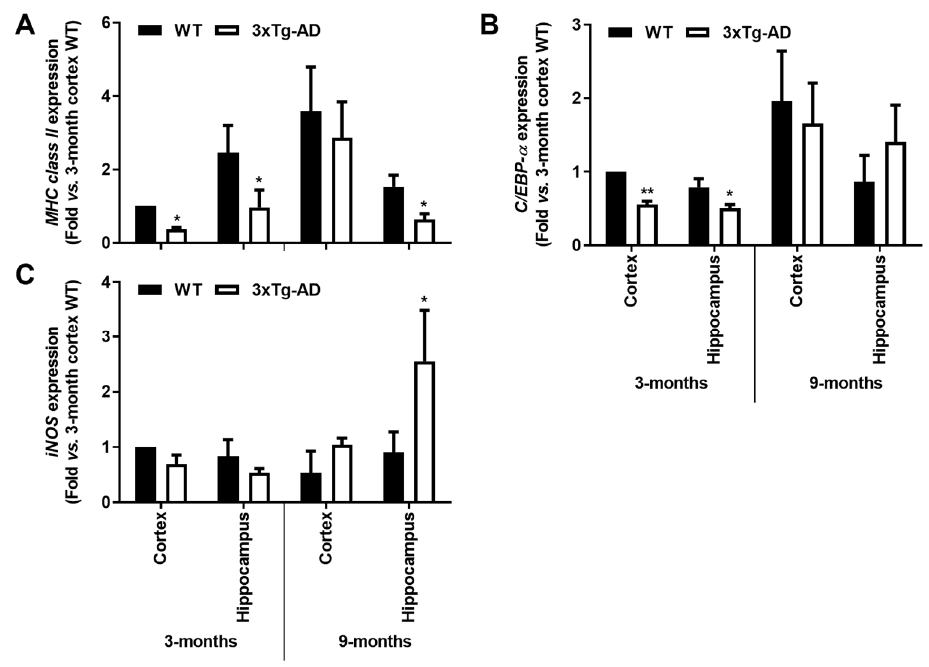
Figure 5. Microglia-associated MHC-II and C/EBP- α pro-inflammatory markers are downregulated in the hippocampus and cortex from the 3-month-old 3xTg-AD mice, while iNOS induction is apparent in 9-month-old hippocampal mouse samples. Brain samples were collected from wild-type (WT) and 3xTg-AD animals at 3 and 9 months and analyzed for ( A )